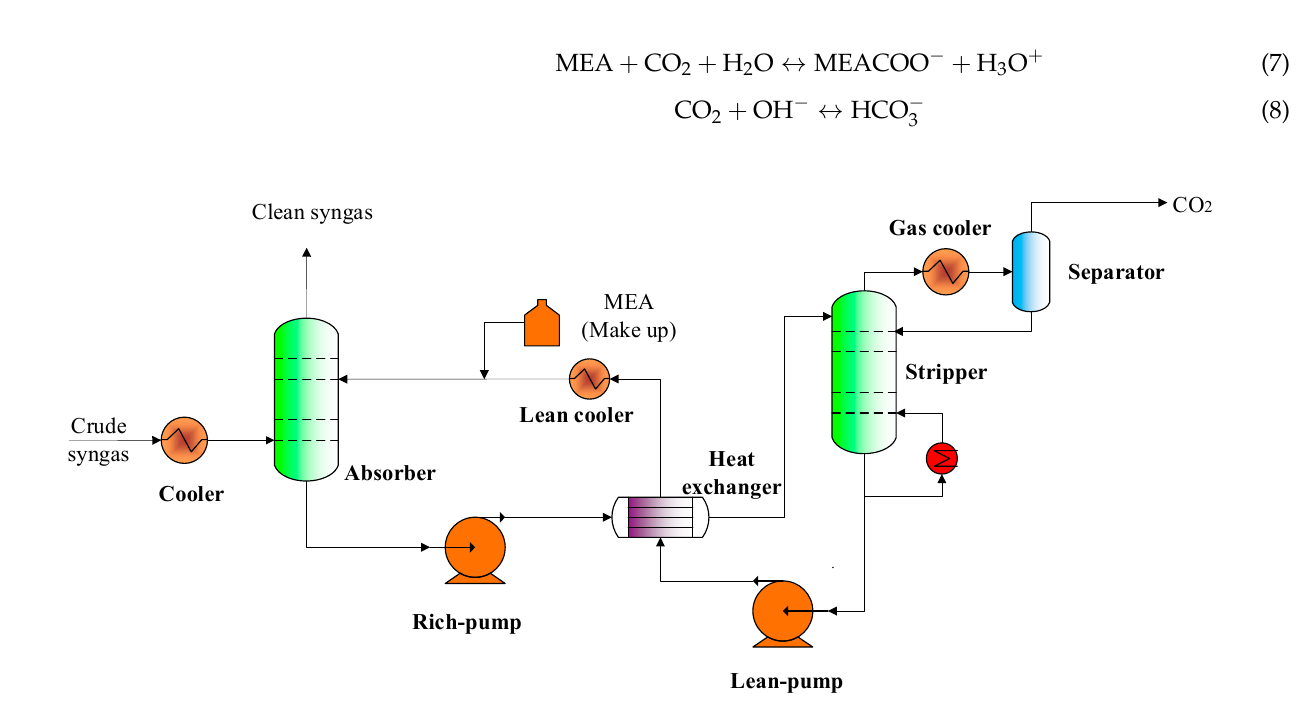
Figure 4. Simplified simulation flowsheet of the MEA technology.